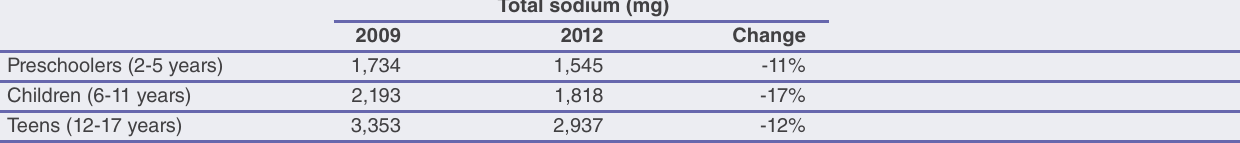
Total calories (kcal)